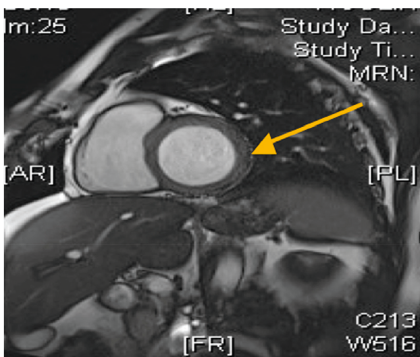
Figure 1: Short-axis view of the cardiac MRI demonstrating a normal left ventricular size and features consistent with myocarditis (arrow).